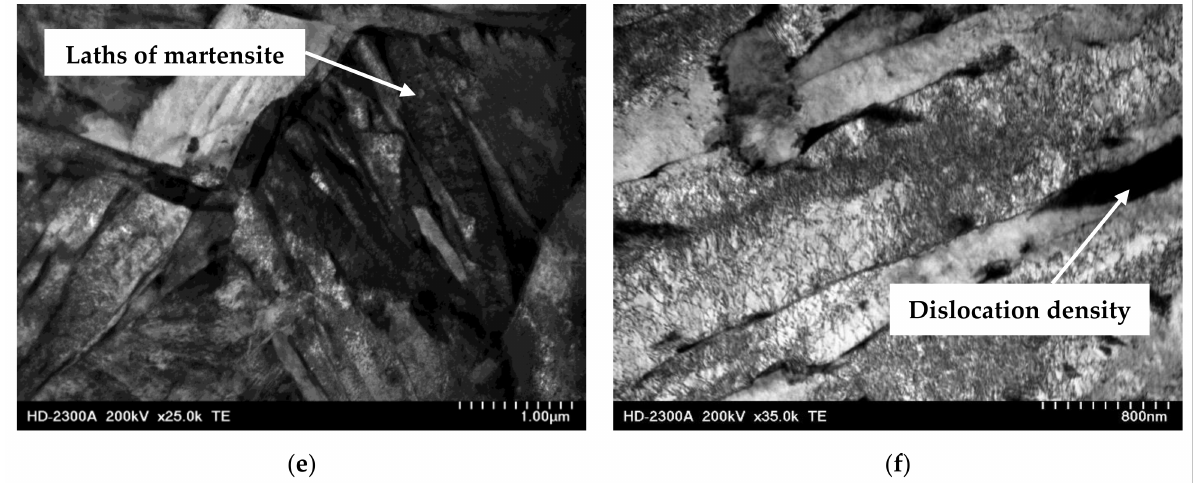
Figure 10. Microstructure of the welded joint made of steel S960QL: ( a ) fusion line (SEM), ( b ) HAZ (SEM), ( c ) weld (SEM), ( d ) base material—martensite with visible dislocations (STEM), ( e ) martensite observed in the HAZ (STEM), and ( f ) laths of martensite in the weld with a visible increase in dislocation density